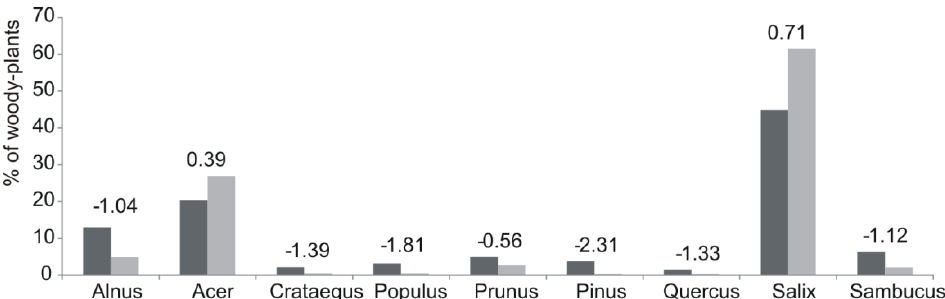
Figure 1. Woody plant genera available (in dark gray) and browsed by beavers (in light gray) with the electivity values (Ivlev’s electivity index with Jacob’s modification) in all the transects located along the Gwda River. Only the genera with an abundance above 0.5% are included in the figure.